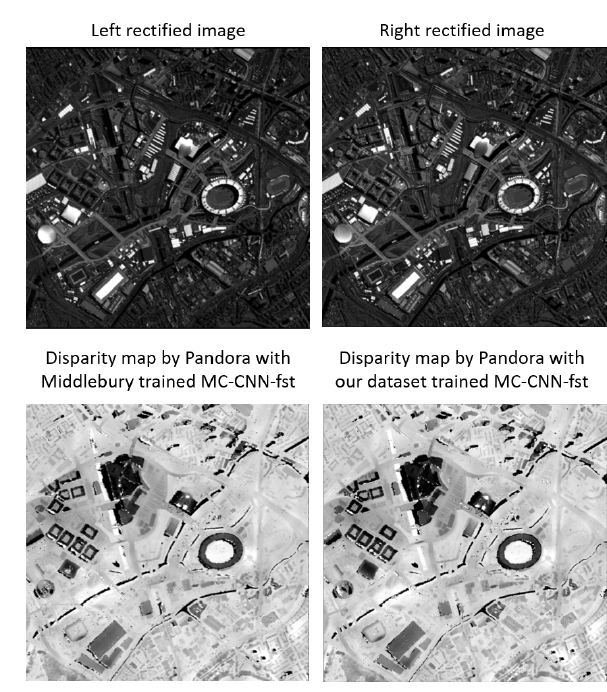
Figure 7. Top: rectified images pair extracted from a WV03 Figure 8. Top: rectified images pair extracted from a PHR-1A single pass acquisition over Buenos Aires. Bottom: disparity single pass acquisition over London. Bottom: disparity maps maps computed by the Pandora pipeline, using MC-CNN-fst computed by the Pandora pipeline, using MC-CNN-fst trained trained either on Middlebury (left), or on our preliminary ground either on Middlebury (left), or on our preliminary ground truth truth dataset (right). dataset